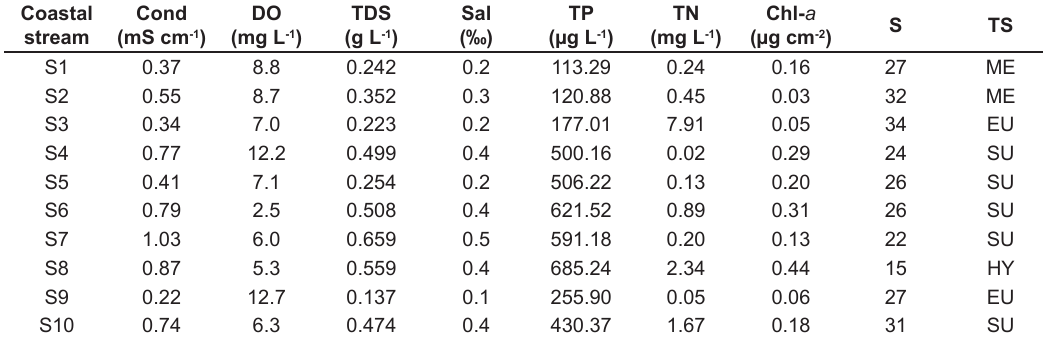
Table 1. Data obtained from 10 coastal streams on southernmost Brazil. Coastal stream